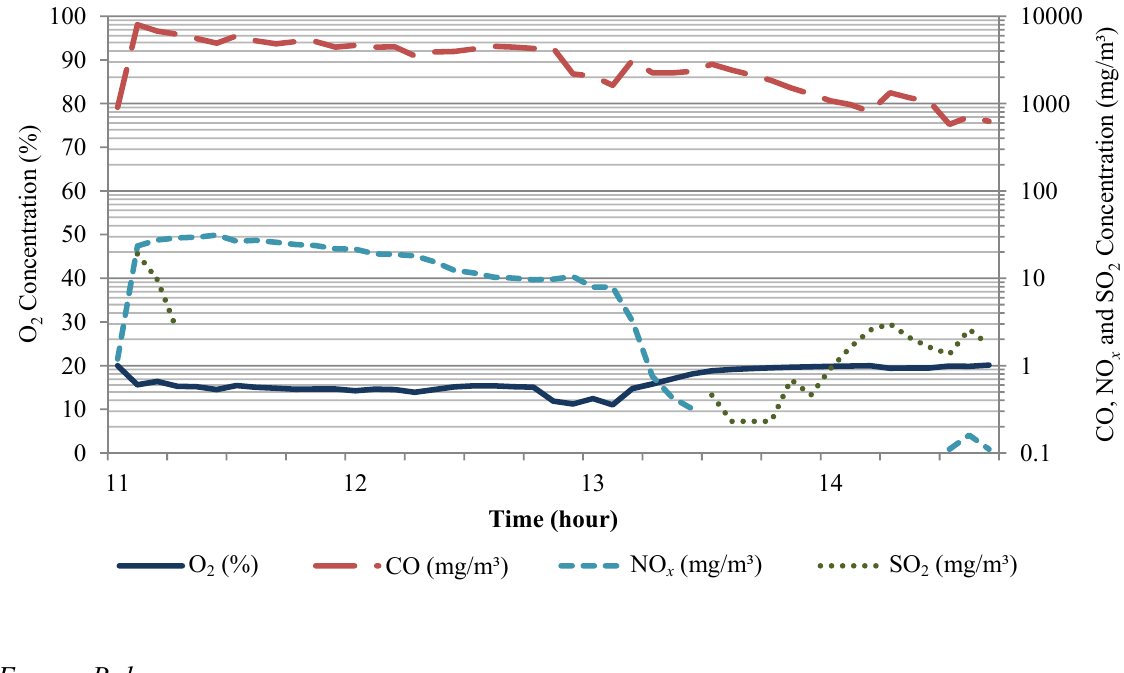
Figure 4. Typical flue gas emission concentrations for CS (bale C14